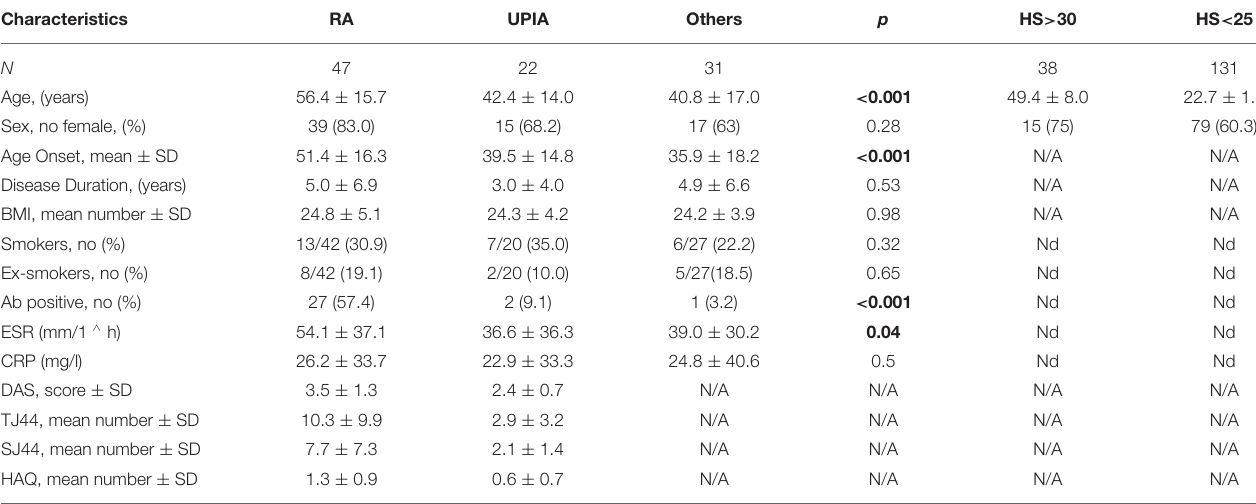
TABLE 1 | Demographic, immunological, and clinical characteristics of patients with arthritides and healthy controls. Characteristics